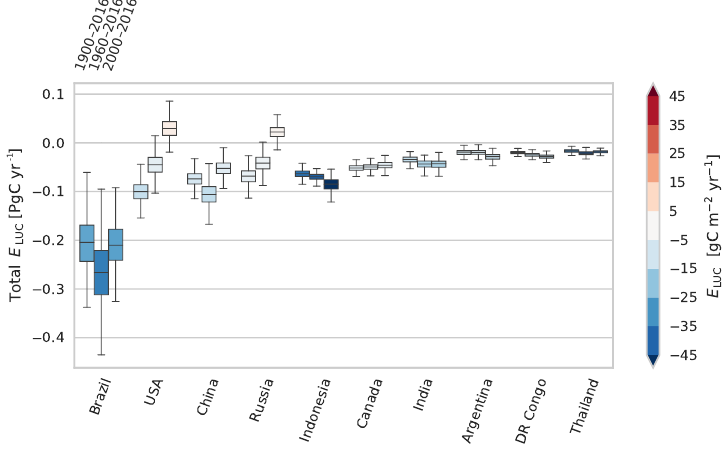
Figure 6. Overview of 10 countries with the highest overall contribution to emissions due to land-use change from 1901 to 2016 in the model ensemble M gross , net . The three columns of the bar plot of each country show the total land-use change flux from 1900 to 2016, 1960 to 2016 and 2000 to 2016 respectively. The color of the bar plot corresponds to the land-use change flux per unit area from the respective country and